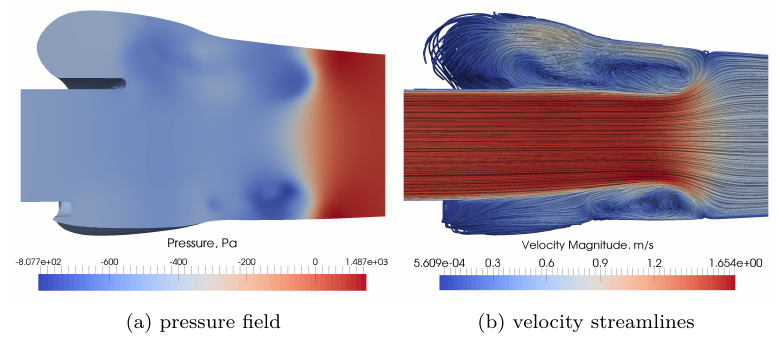
Figure 3. Numerical solution of flow through the aortic valve problem at time moment t = 0 . 158 s